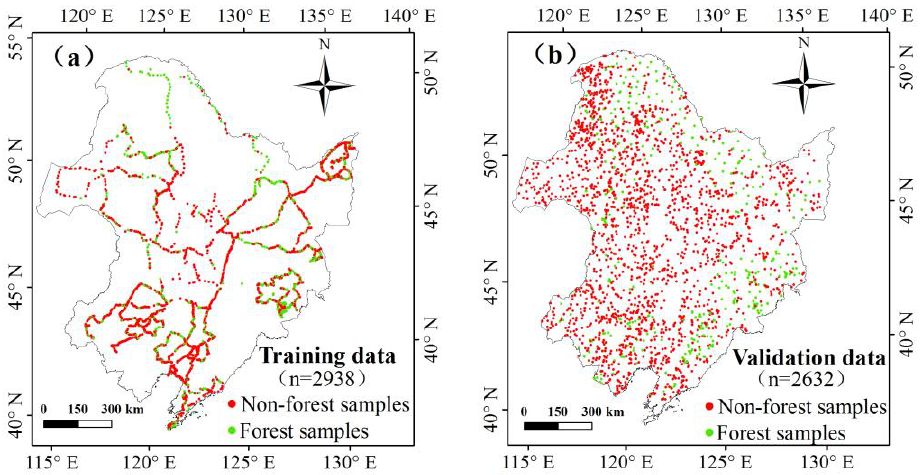
Figure 2. Location of training data ( a ) and validation data ( b ) in Northeast China.